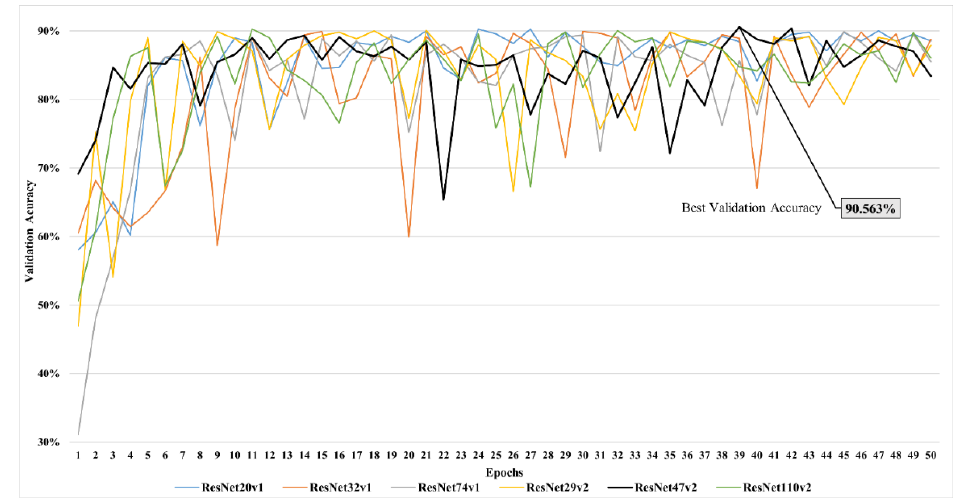
Figure 12. Training accuracy curves for the various ResNet models.